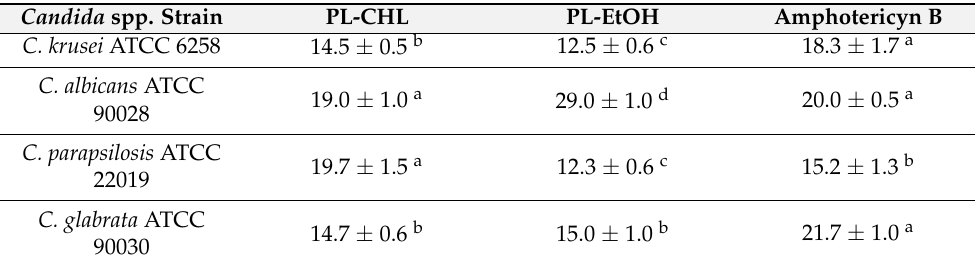
Table 1. Inhibition halo determined by chloroform and ethanol extracts of C. colocynthis plantlets (PL-CHL and PL-EtOH respectively) on Candida cultures. Values are expressed, in mm, by means of three replicates ± S.D. Amphotericyn B (AmpB) was used as the control for anticandidal activity. Different superscript letters indicate statistically significant differences ( p <